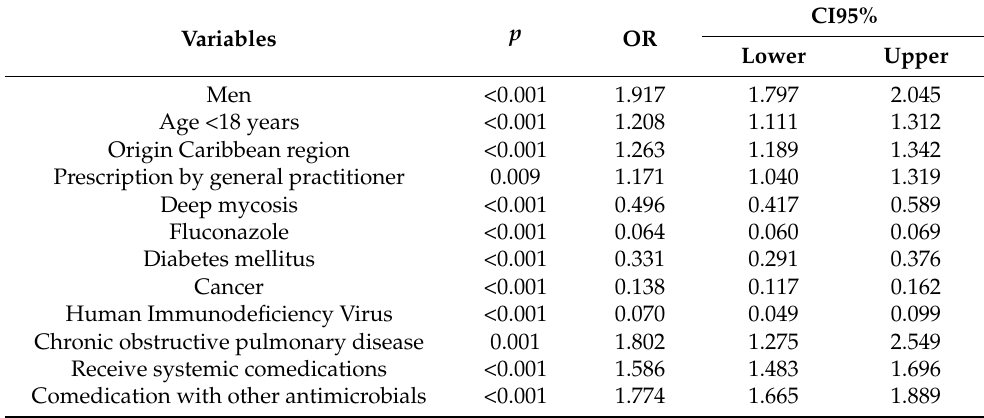
Table 3. Variables related to unapproved uses of systemic antifungals by binary logistic regression in 35,824 outpatients, Colombia,